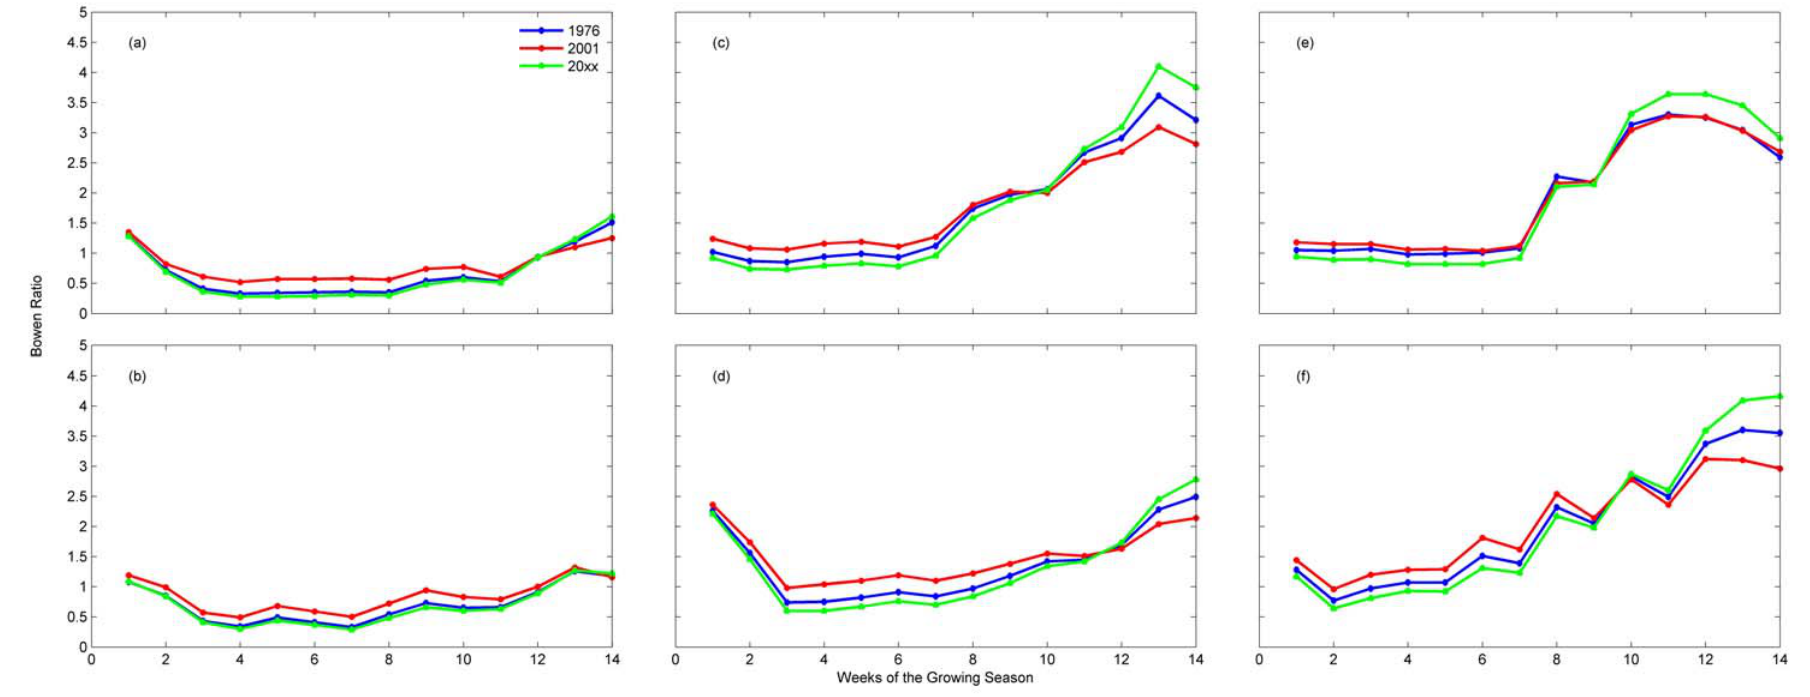
Figure 5. Mean daily land-use-weighted growing-season Bowen ratios in 1976, 2001 and 20xx at representative weather stations; ( a ) Nipawin, ( b ) Brandon, ( c ) Lethbridge, ( d ) Saskatoon, ( e ) Medicine Hat, and ( f ) Vauxhall. Stations (a) and (b) represent Black soil zone, (c) and (d) represent Dark Brown soil zone and (e) and (f) represent Brown soil zone. Year 20xx is a hypothetical year for which all arable lands are assumed to be covered by annual crops. Week #1 is the last week of